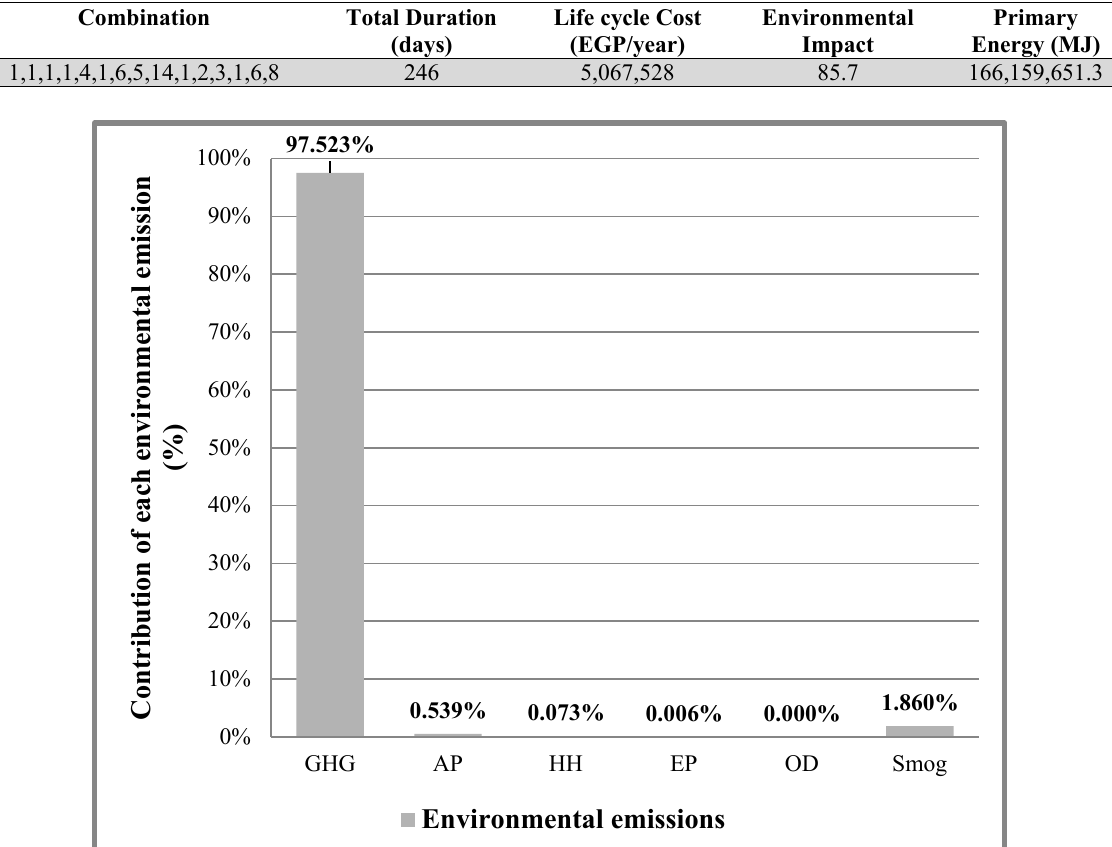
Attributes associated with the chosen solution